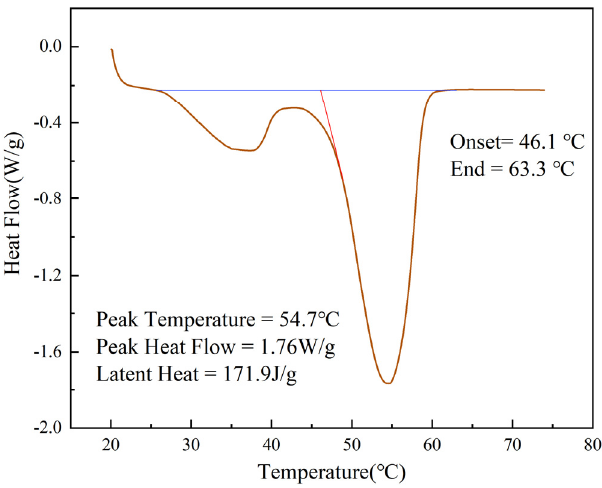
Figure 4. Results of DSC measurement of paraffin RT60.